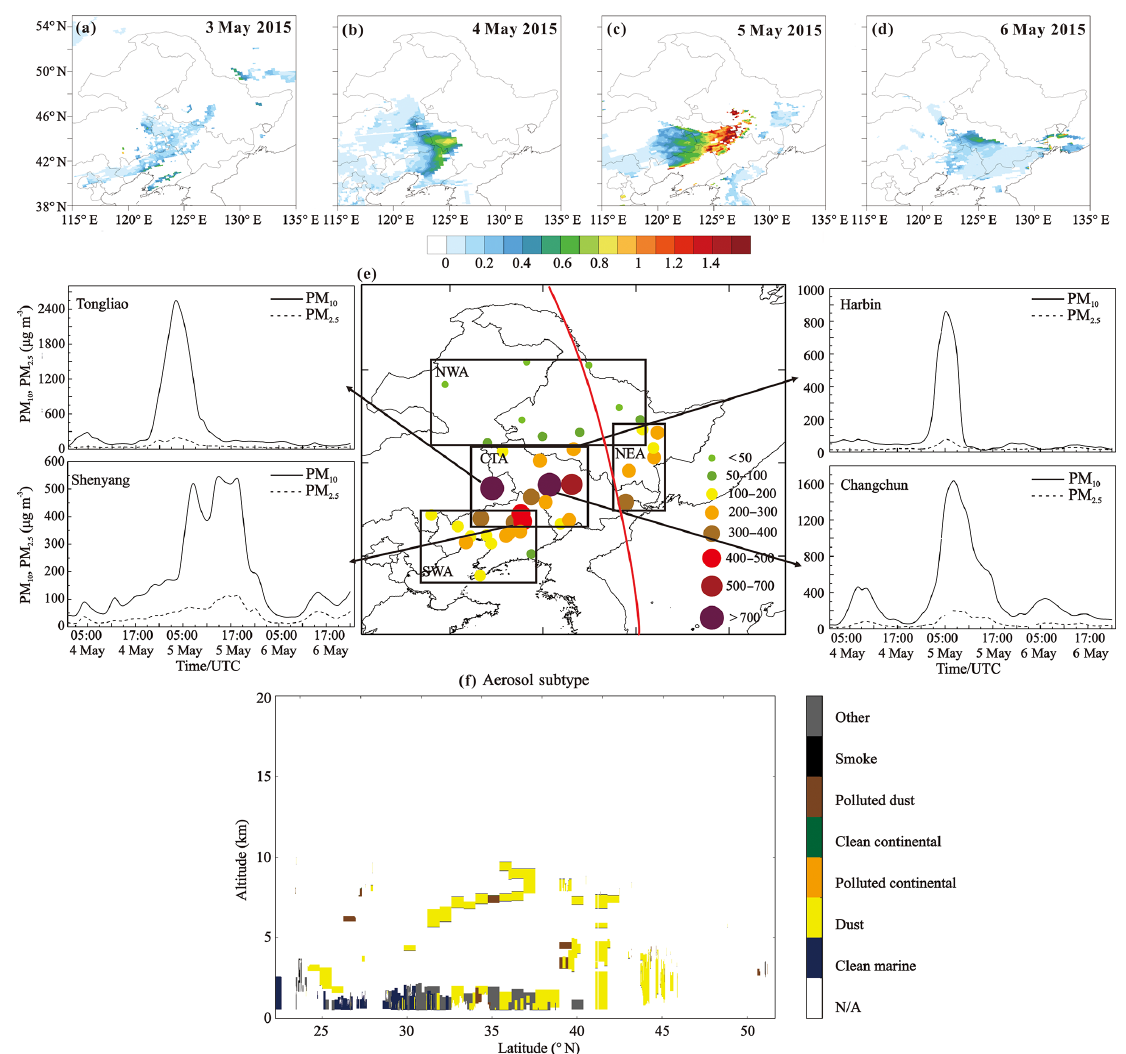
Figure 2. Satellite and ground observations of the 5 May 2015 dust event over northeastern China: (a–d) Daily MODIS aerosol optical depth (AOD) at 550nm before, during, and after the storm; (e) daily mean PM 10 concentrations (µgm − 3 ) measured at four ground sites (Tongliao, Changchun, Harbin, and Shenyang) on 5 May 2015 and hourly PM 10 (solid line) and PM 2 . 5 (dashed line) variations during the dust period. The red line in (e) indicates the path of the CALIPSO satellite, and CALIPSO aerosol subtype between 04:30 and 04:43UST are shown in (f)